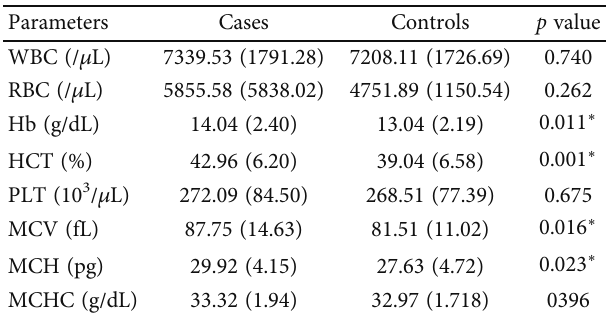
Table 3: Hematologic indices in patients with breast cancer and healthy